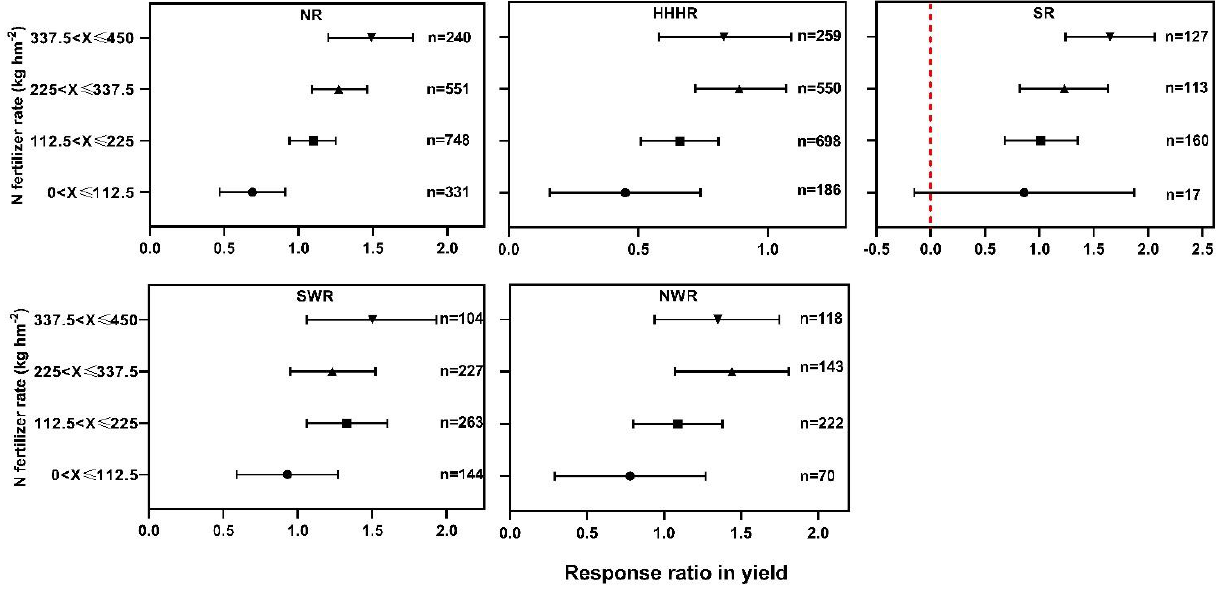
Figure 3. The effects of N fertilization levels on maize yield in each geographic region. NR: Northern region; HHHR: Huang–Huai–Hai region; SR: Southern region; SWR: Southwestern region; NWR: Northwestern region. The error lines indicate the 95th percentile bootstrap confidence intervals. The n values represent the corresponding number of observations (total number of control and treatment values). Yield with N fertilization is a treatment value, whereas yield without N is a control